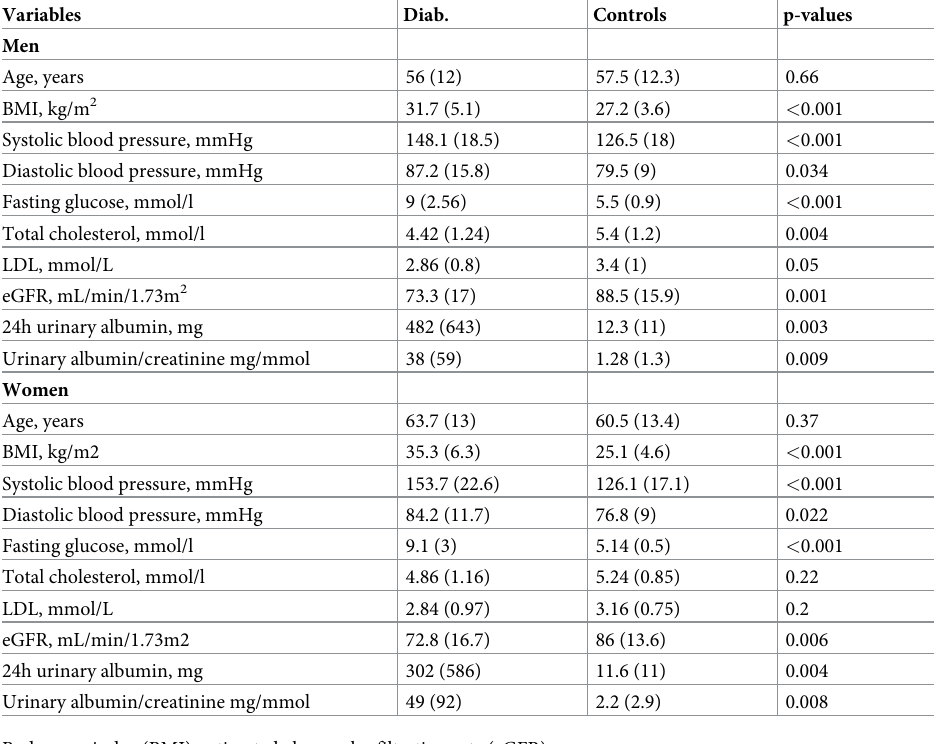
Table 1. Characteristics diabetic patients-healthy controls. Variables Diab. Controls